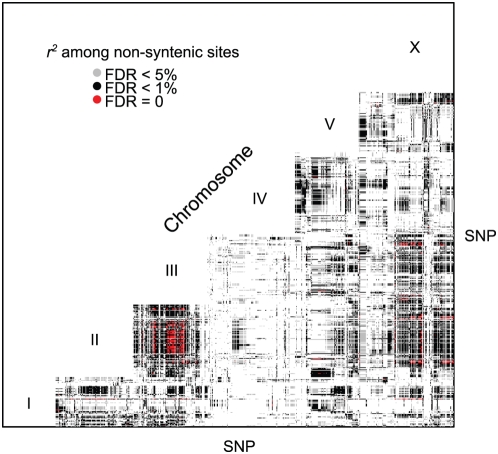
Linkage disequilibrium among unlinked sites.Every pair of unlinked SNPs with a significant r2 at the specified false discovery rate is plotted. The axes represent the physically ordered SNPs spaced equally and not by distance.